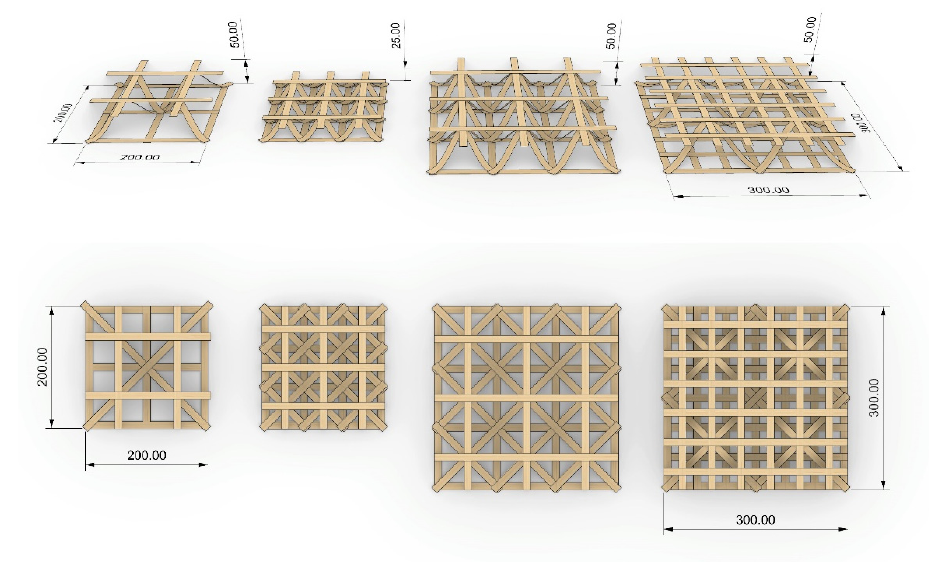
Figure 10. 3D lattice layout studies (dimensions in mm).